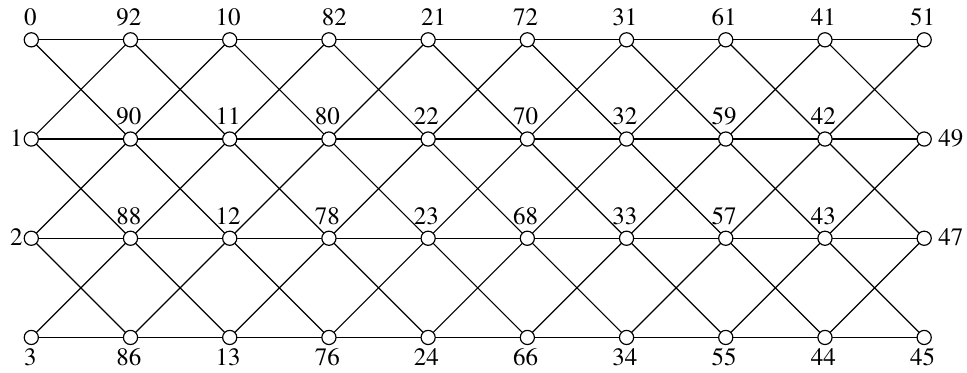
Figure 4: 3-divisible α -labeling of S